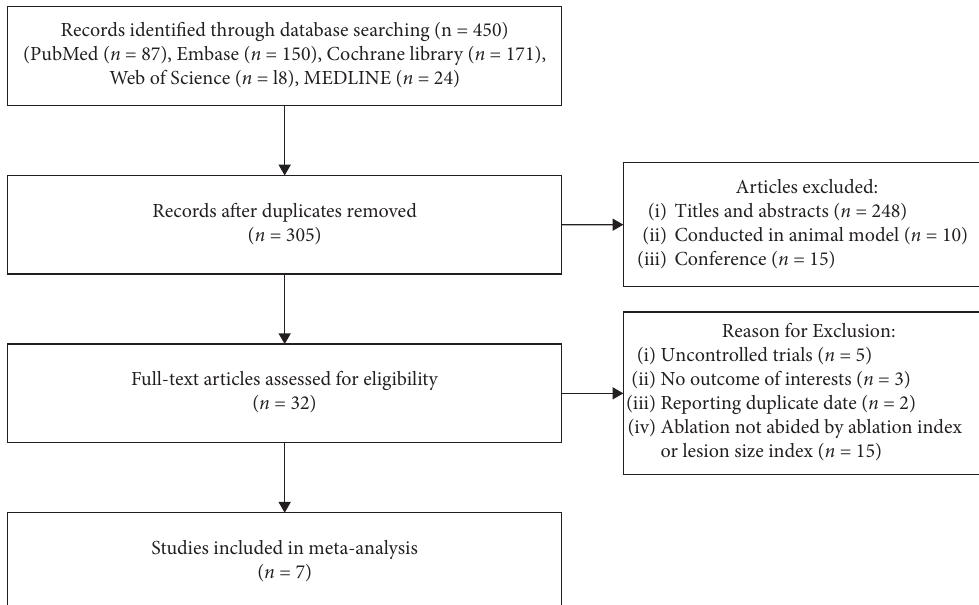
Figure 1: The flowchart of the literature search